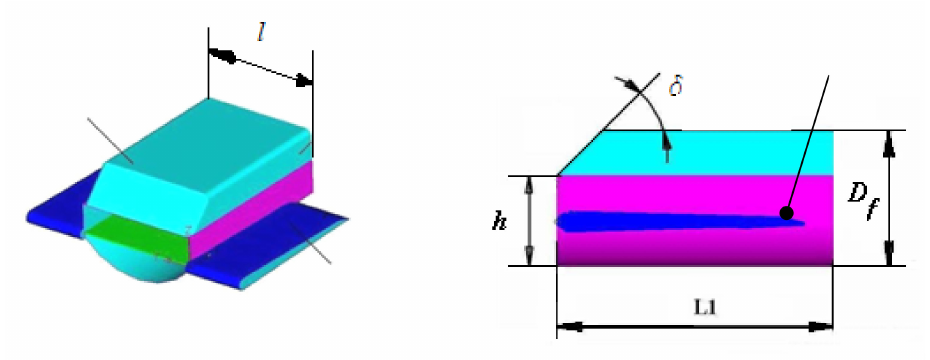
Figure 5. The central fuselage—Part